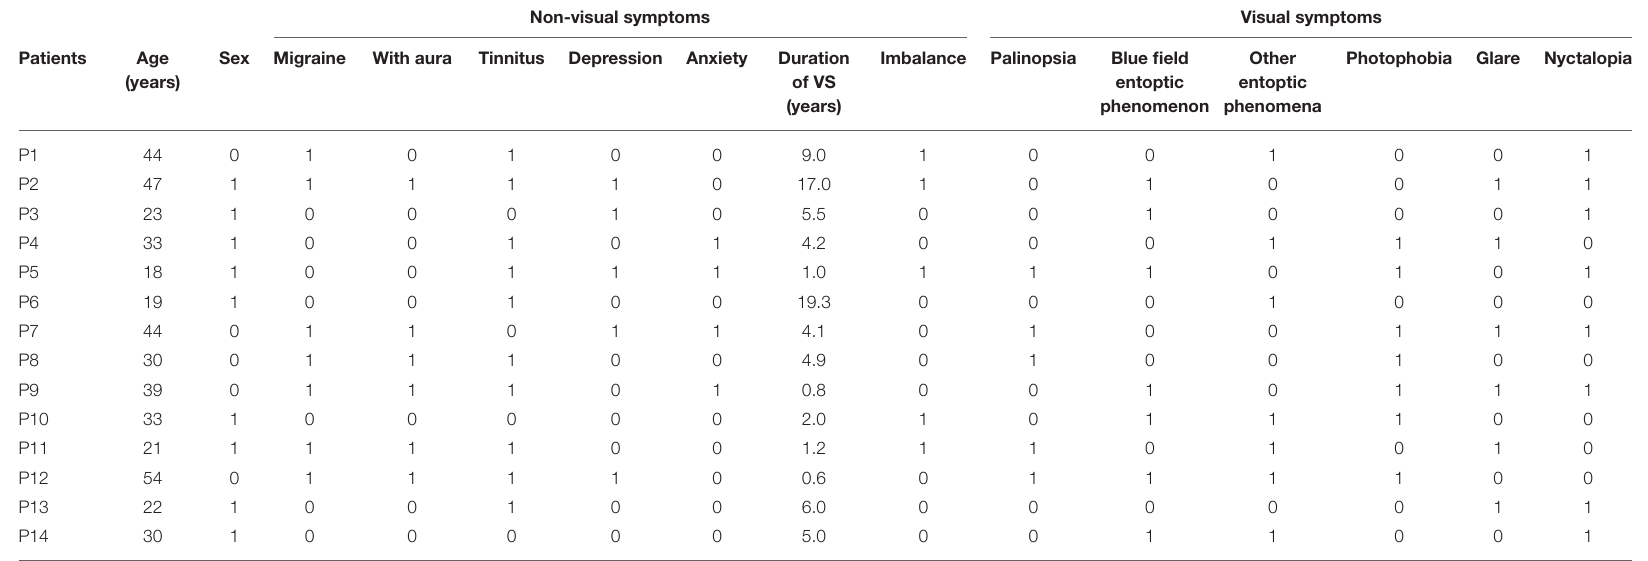
For sex, 1 = male, 0 = female. For all other variables, 1 = present, 0 = absent. Six of seven patients with migraine demonstrated visual